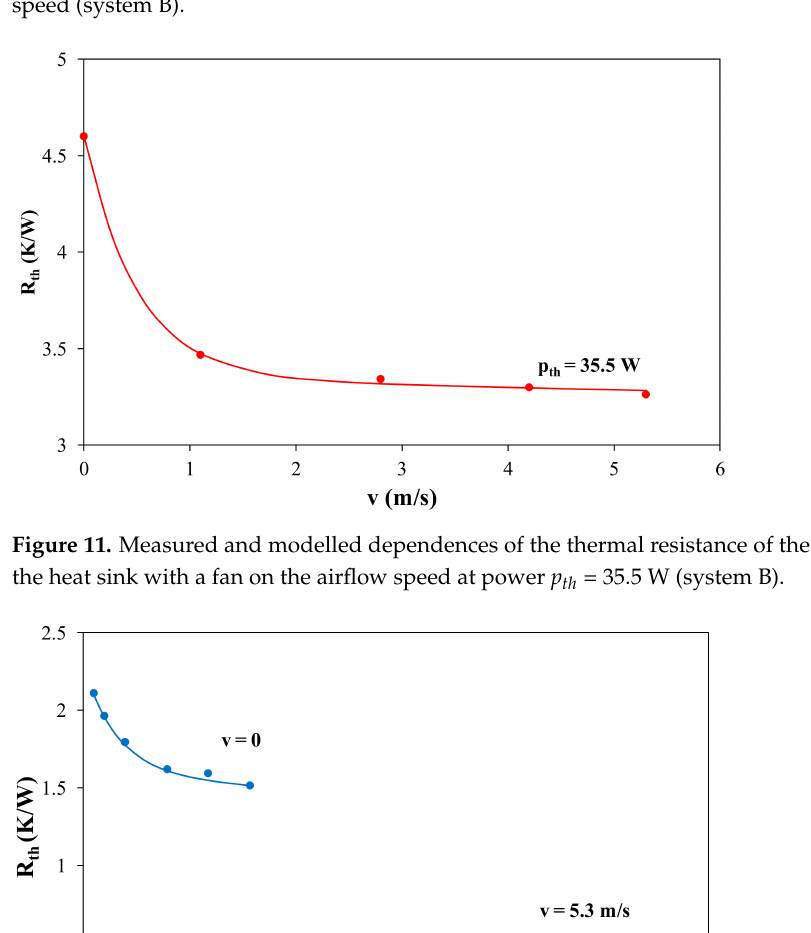
Figure 10. Measured and modelled dependences of the thermal resistance of the resistor situated on the heat sink with a fan on the power dissipated in the resistor at selected values of the airflow speed (system B).